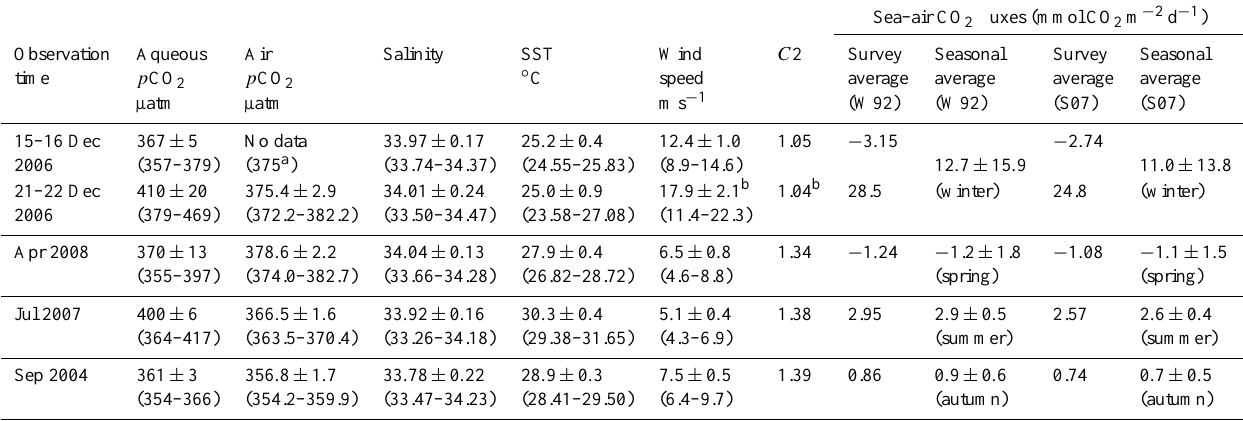
Table 6. Summary of p CO 2 , salinity and SST along cruise tracks, monthly satellite-derived wind speed, and sea–air CO 2 flux estimation